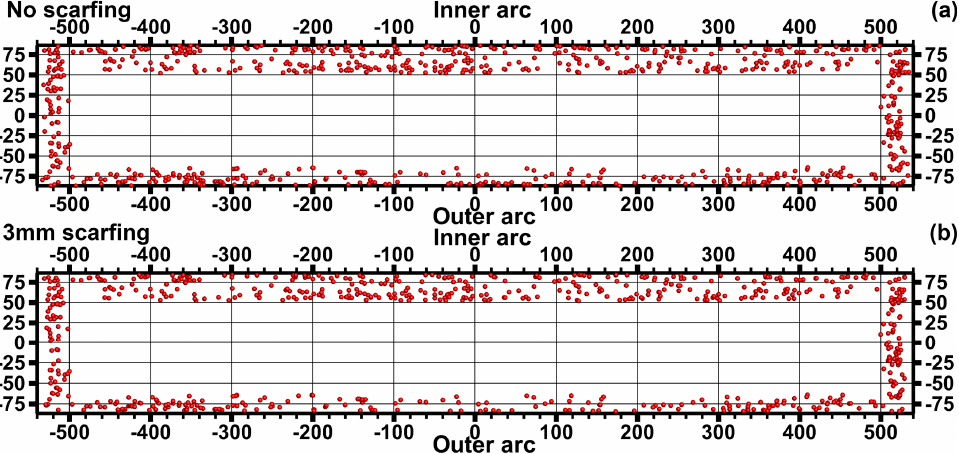
Figure 7. The distribution of inclusions in the intermediate slab after R1 pass: the case without scarfing ( a ) and the case with 3 mm scarfing ( b ).